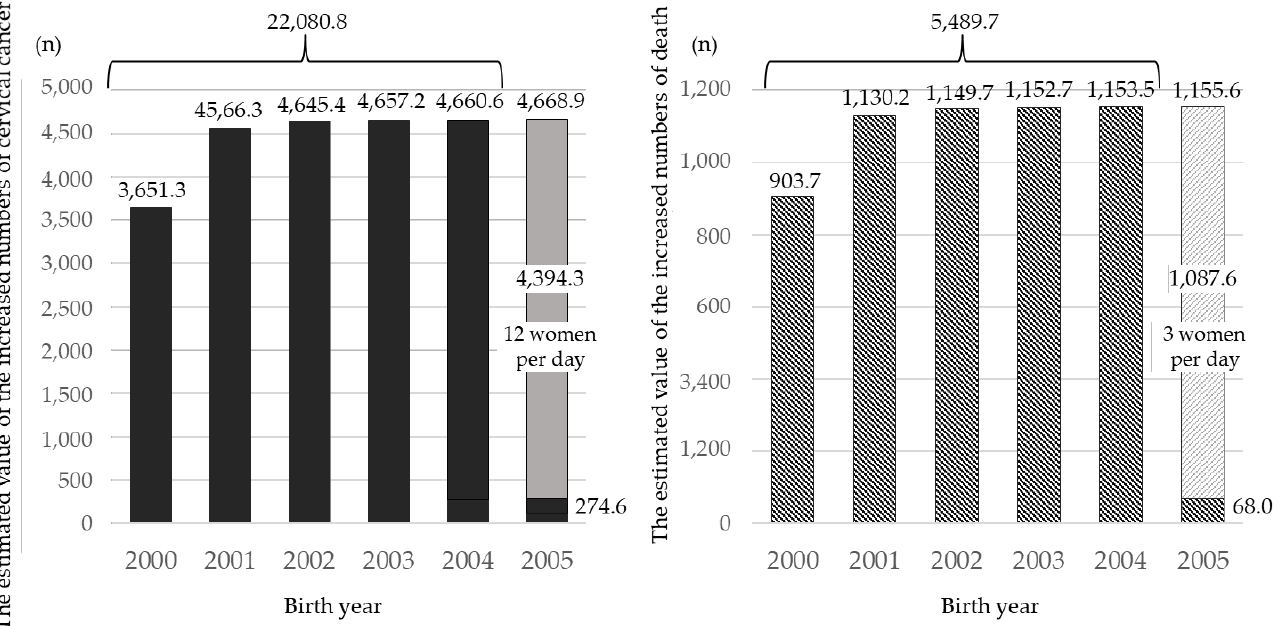
Figure 1. The estimated value of the increased numbers of incidence and death.